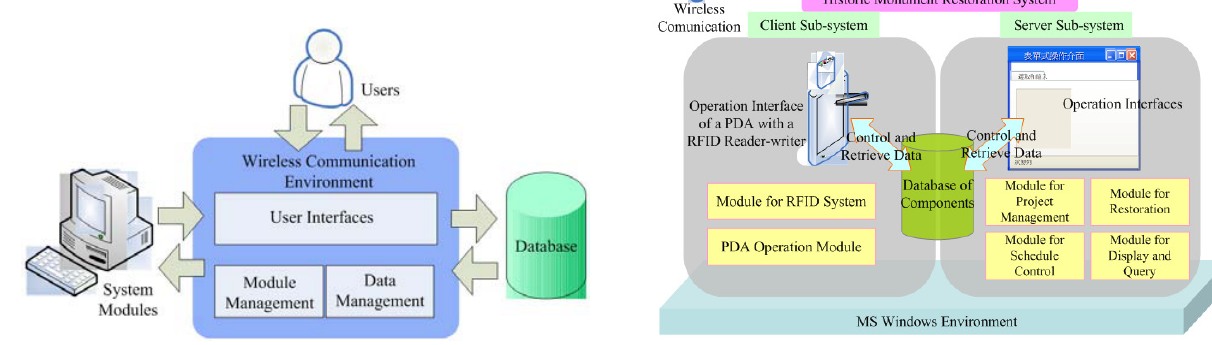
Fig. 4. System concept Fig. 5. System structure of functional modules